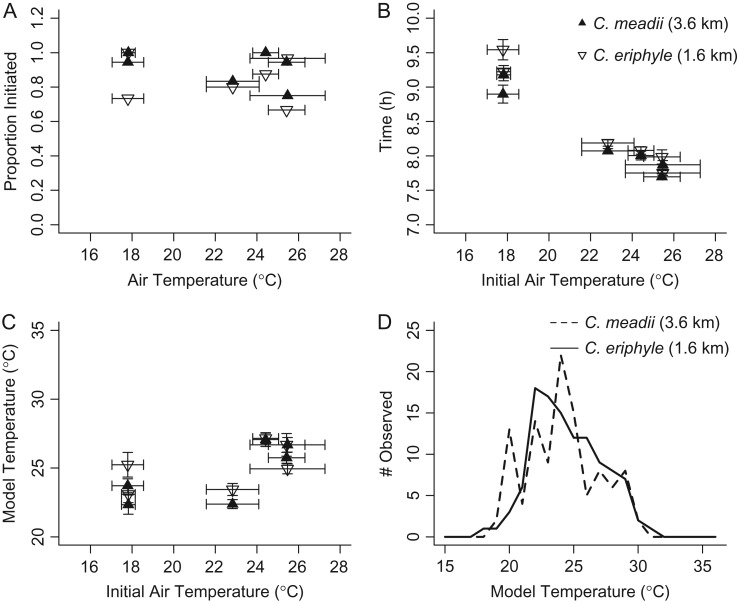
Results from the common garden between C. eriphyle (open symbols) and C. meadii (closed symbols). (A) The two species do not differ significantly in their probability of flight initiation (mean ± 95% confidence intervals). (B) Cooler initial temperatures lead to later flight initiation times (hour, means ± SEM) in both species. (C) Colias meadii initiate flight at cooler temperatures (in degrees Celsius, means ± SEM). (D) The distributions of initiation temperatures binned by 0.5°C for the two species.